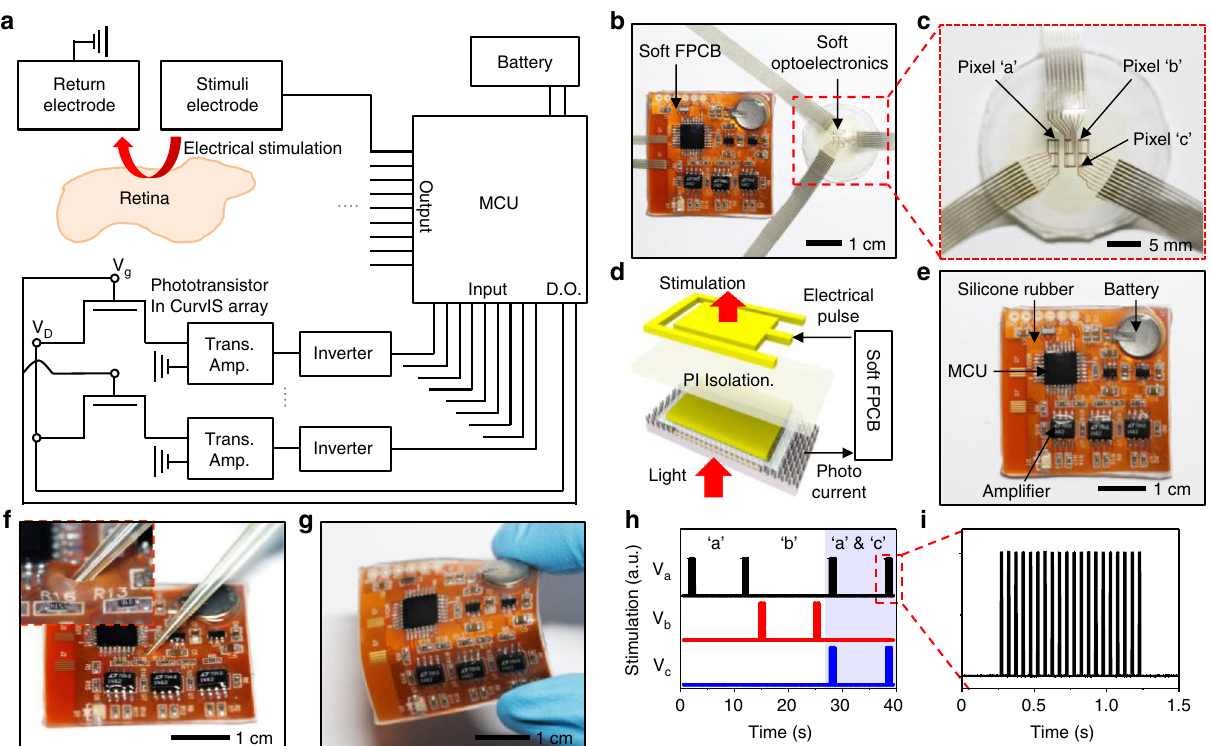
Fig. 6 Soft fl exible printed circuit board that integrates the CurvIS array with UNE. a Schematic drawing of the electronics for detecting the external light (bottom) and for applying the stimulation (top). b Optical camera image of the CurvIS array and the UNE on the eye model, which are connected by the soft FPCB. c Magni fi ed optical camera image of the vertically stacked the CurvIS array and the UNE. d Schematic illustration of the phototransistor (bottom) and the stimulation electrode (top) stacked together and connected via the soft FPCB. e Optical camera image of the soft FPCB. f , g Optical camera image of the soft FPCB under poking f and bending g . h , i Generated electrical pulses at three different pixels by responding the light on/off h , and magni fi ed electrical pulse